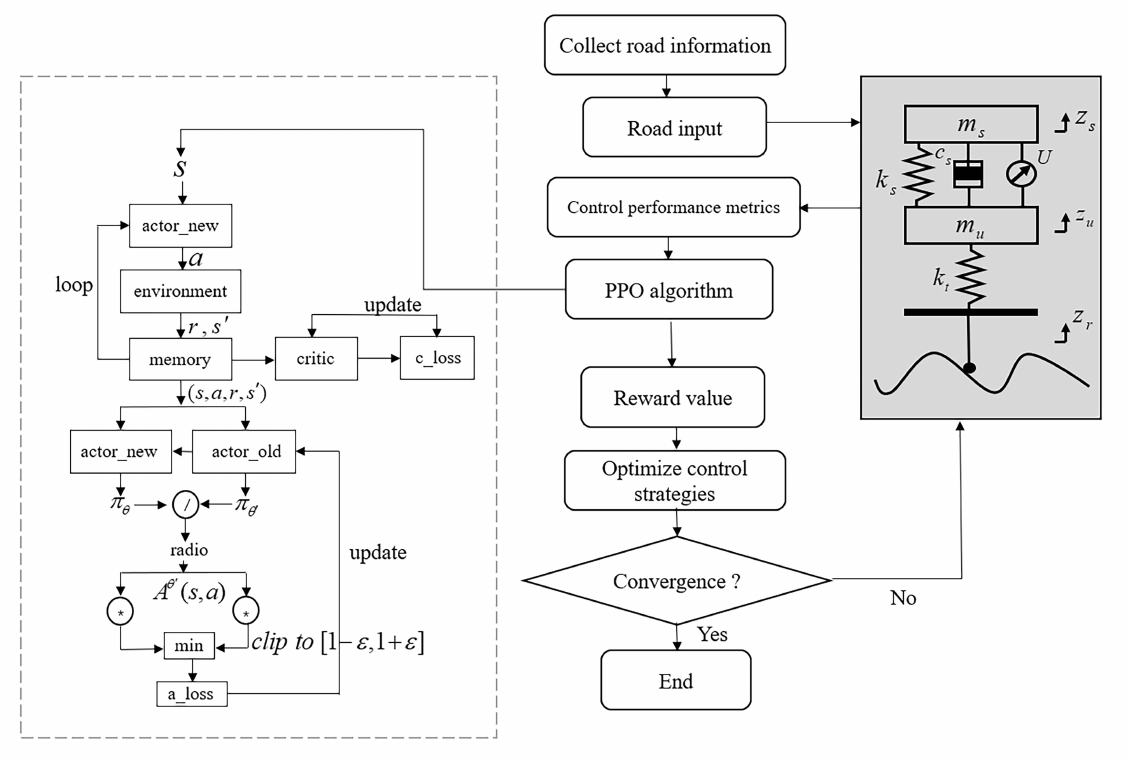
Figure 2. The control structure of semi-active suspension based on